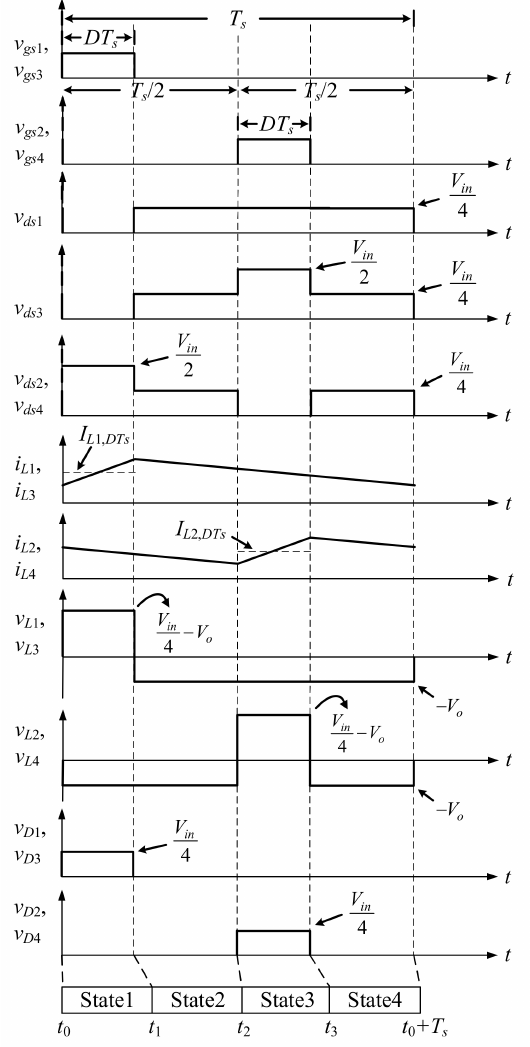
Figure 3. Waveforms relevant to the converter operating in